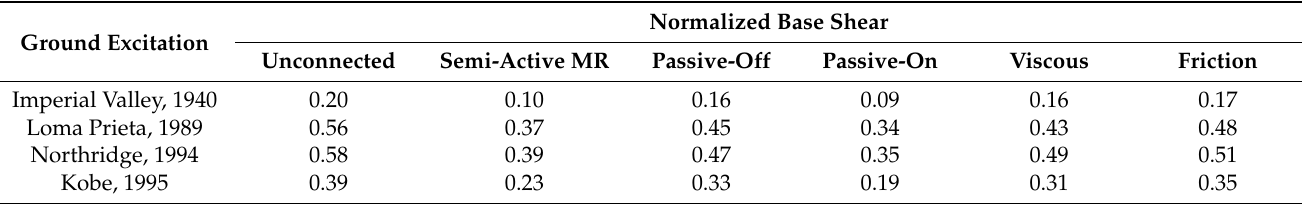
Table 9. Comparison of peak normalized base shear of the coupled flexible building under different control strategies when dampers are arranged in Configuration